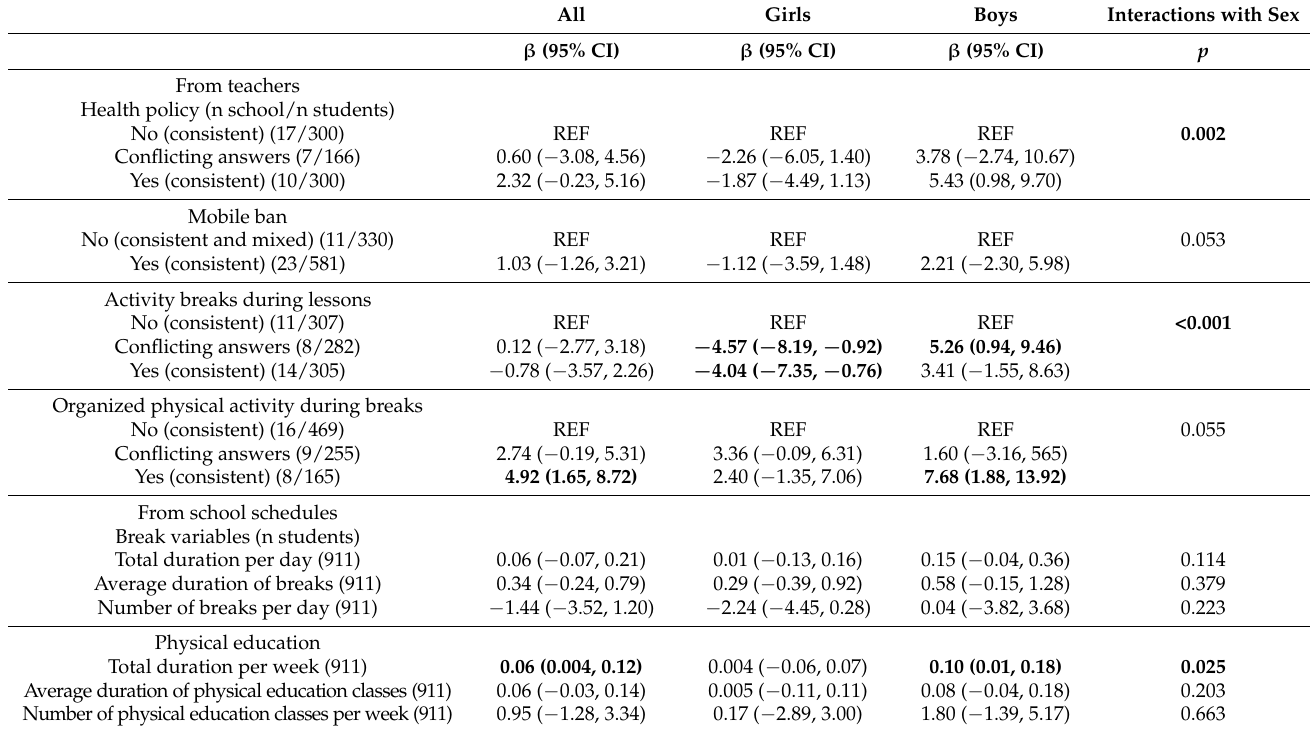
Table 3. Associations between the school environment and the participants’ light physical activity (LIPA) in minutes during school time. All Girls Boys Interactions with Sex